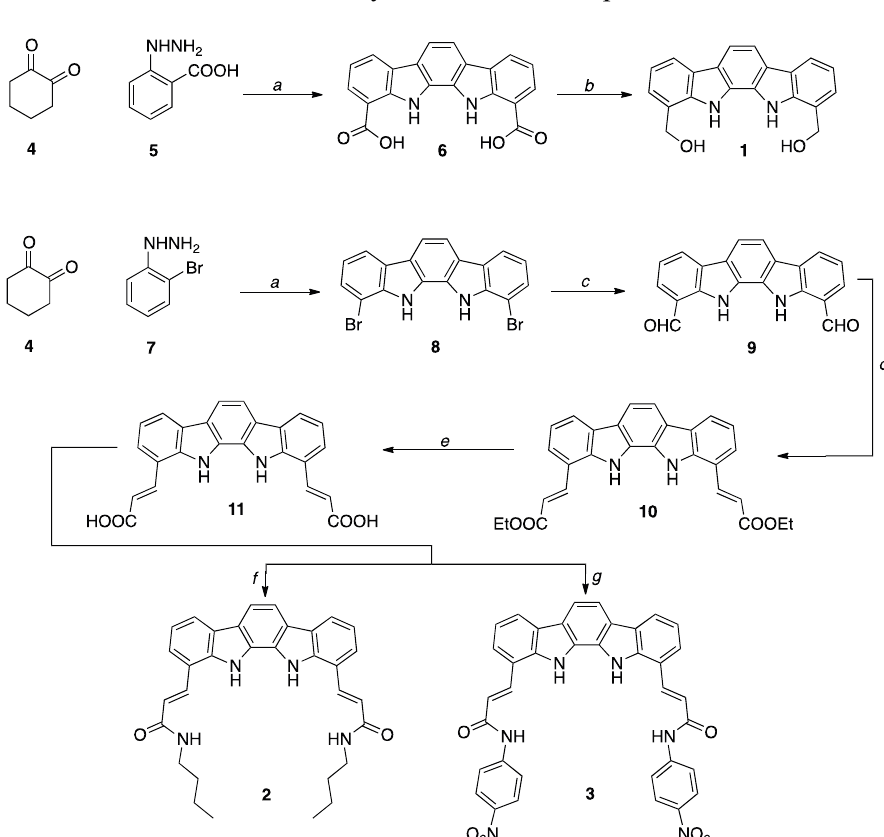
Scheme 1. Synthesis of the